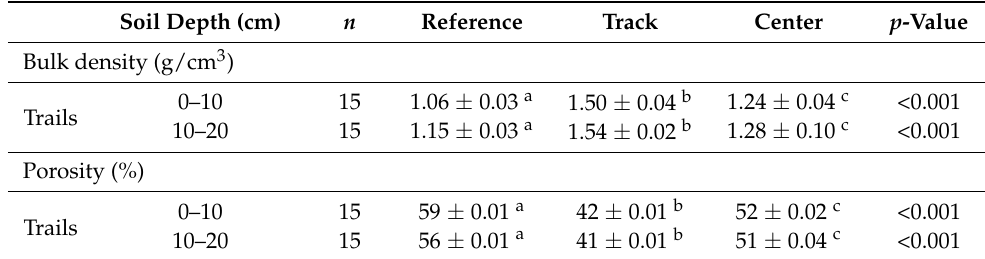
Table 4. Mean bulk density and porosity calculated at reference, track, and center locations in the forwarding trails.